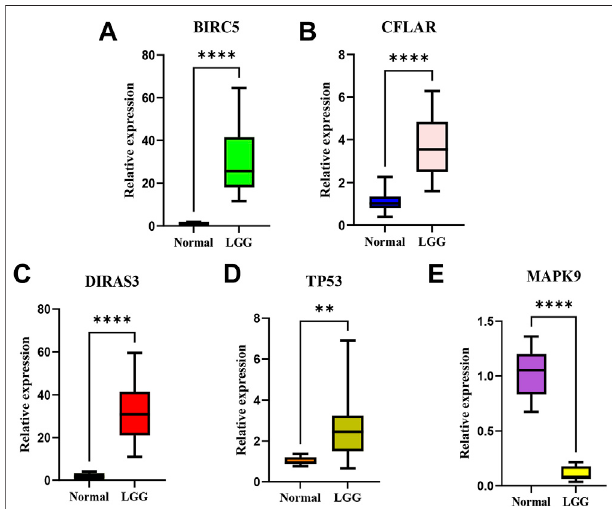
FIGURE 12 | The relative expression levels of the fi ve genes in normal brain tissues and LGG tissues.The BIRC5 (A) , CFLAR (B) , DIRAS3 (C), and TP53 (D) were up-regulated, and MAPK9 (E) was signi fi cantly down- regulated in LGG tissues. ** p < 0.01; **** p <